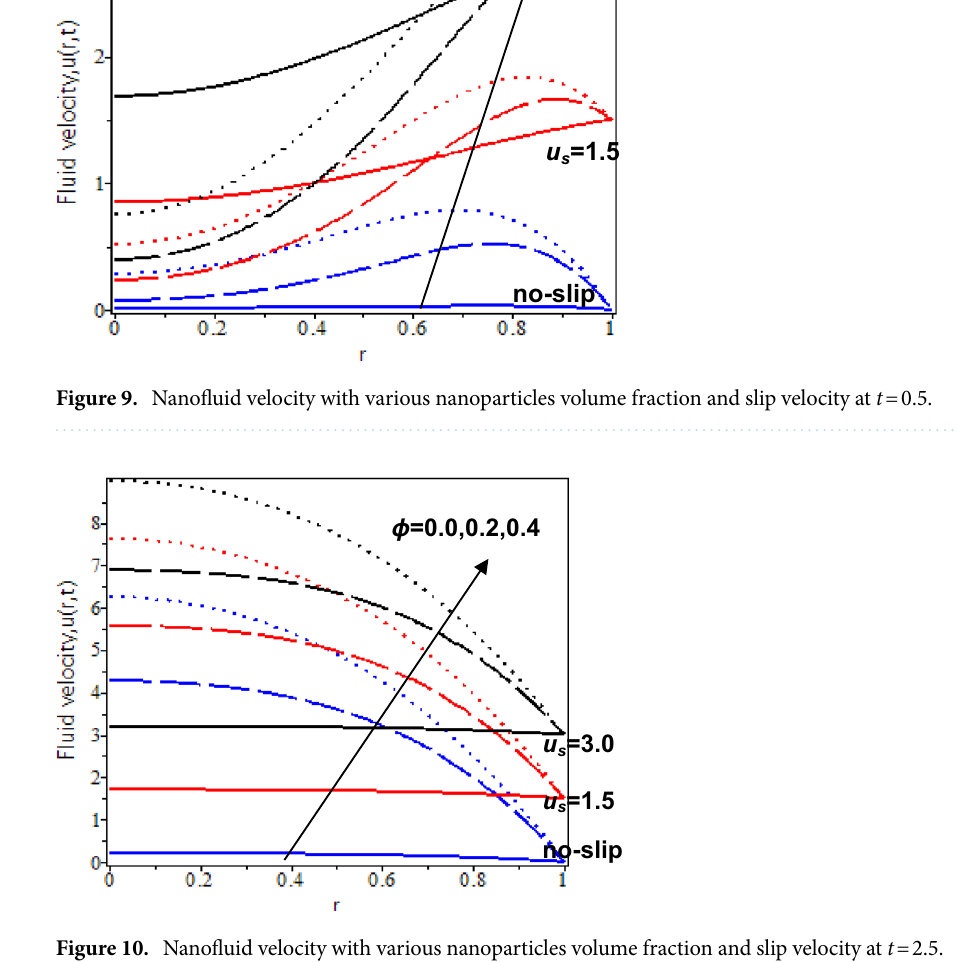
Figure 10. Nanofluid velocity with various nanoparticles volume fraction and slip velocity at t =